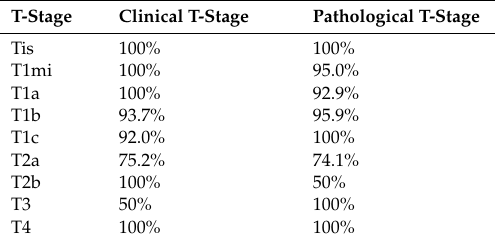
Table 4. Two-year recurrence-free survival rates for each T-stage.